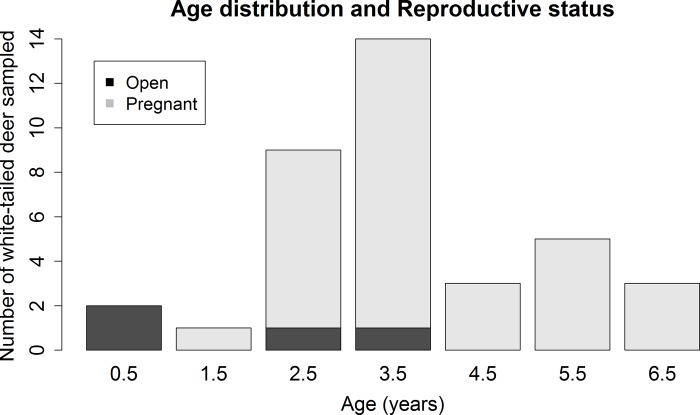
Age distribution and reproductive status of the 37 sampled female white-tailed deer.There were 5 males sampled: 0.5 year old (n = 1), 1.5 year old (n = 3) and 2.5 year old (n = 1) (not displayed in this figure). A total of 11% of female white-tailed deer were open and 89% pregnant.